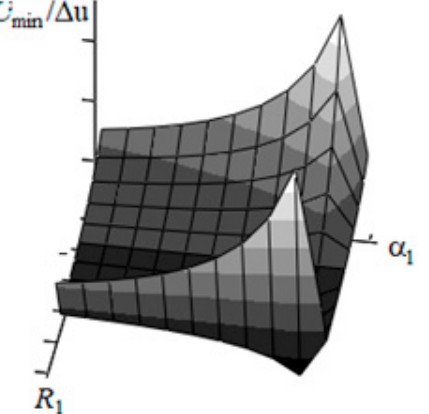
Figure 3. Two-dimensional variation of the reduction of the ratio of quantization counts of an optoelectronic device and an electronic ADC in α 1 = 75, . . . ,95 ◦ and R 1 = 0.005, . . . ,0.015 m parameters variations.